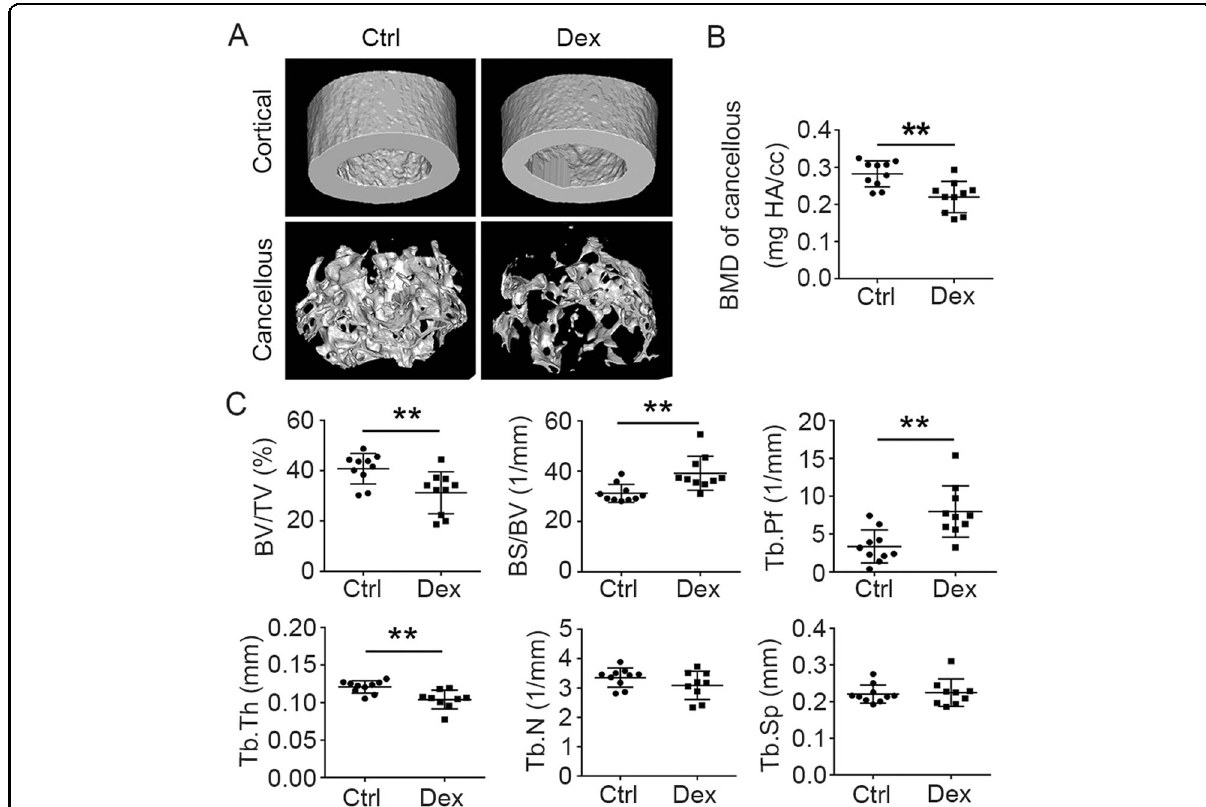
Fig. 1 Bone mineral density decreases after dexamethasone treatment. Micro-CT analysis of femoral bones from WT mice (13 – 14-week-old females) treated with or without Dex (4 weeks of subcutaneous daily injection). A Images of the cortical (top) and cancellous bone (bottom). B Cancellous bone parameters were quantitated and compared between WT mice treated with Dex and untreated controls. BMD bone mineral density. C BV/TV bone-volume/tissue-volume ratio, BS/BV bone surface/volume ratio, Tb.Pf trabecular pattern factor, Tb.Th trabecular thickness, Tb.N trabecular number, Tb.Sp trabecular separation. Bars represent mean ± SD ( n = 10). * p < 0.05; ** p < 0.01; *** p < 0.001; **** p <